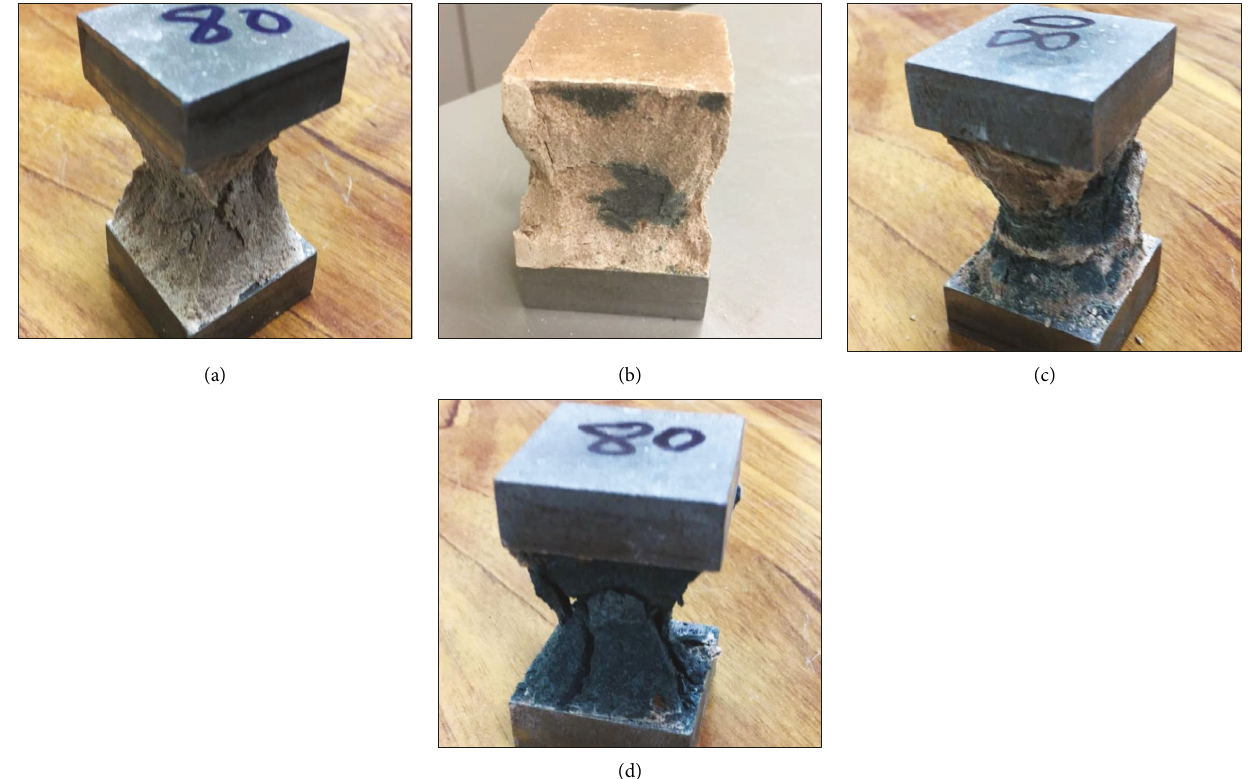
Figure 7: The impacts of various NaOH molar proportion and water amount on the geopolymerisation processes (specimens with 80 and 20 percent of GGBS and MK, respectively) the pictures have been lected after conducting compressive strengths test; (a). 40% water proportion, 12% NaOH; (b).12M NaOH, 40% water proportion (c).1% SP, 20% water proportion, 12% NaOH; (d).12M NaOH, 20% water proportion, 1%